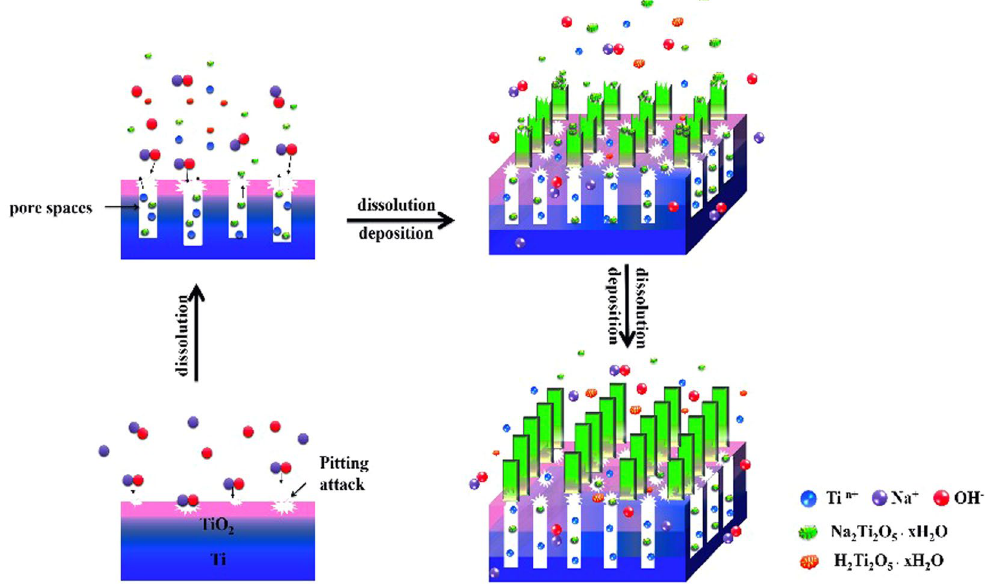
Figure 6. Schematic formation mechanism of flake-like nanostructured titanate layer on Ti substrate.